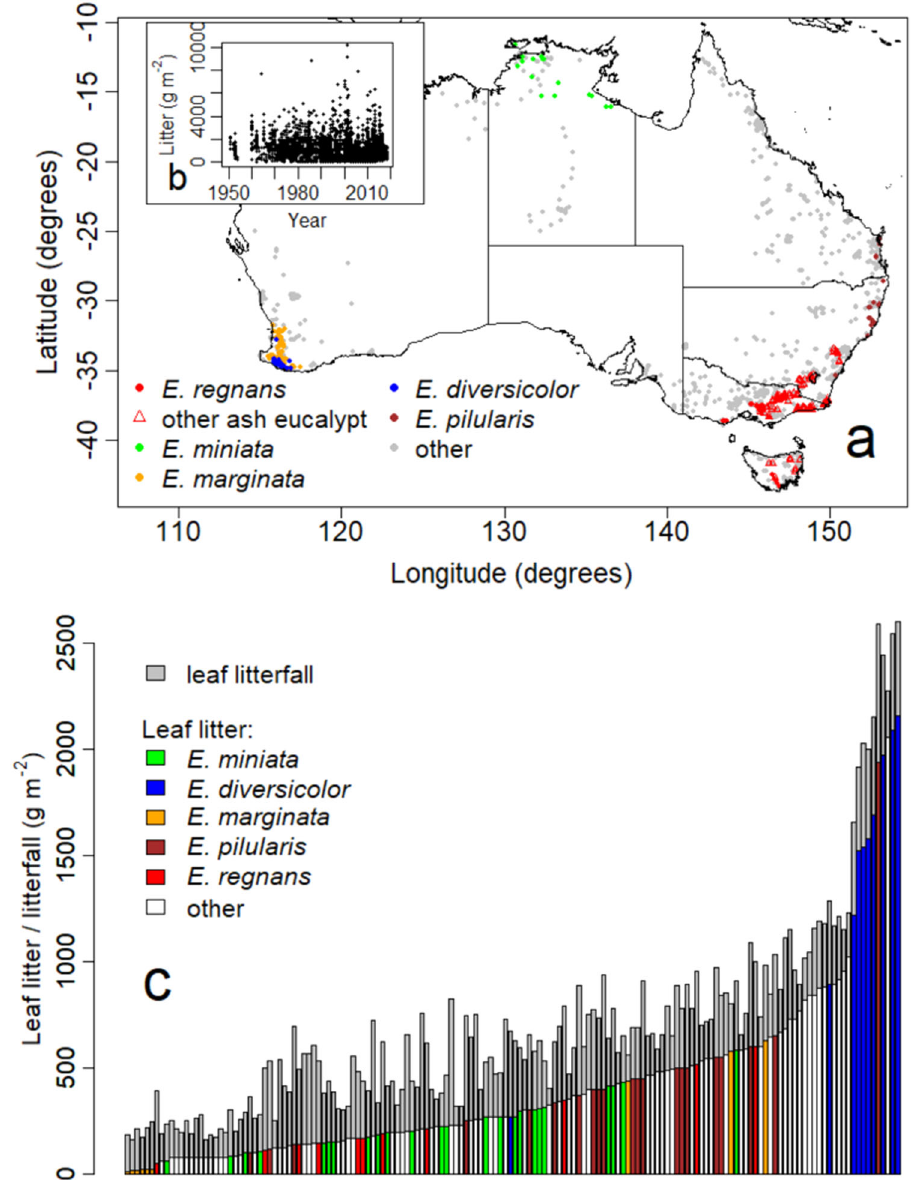
Fig. 1 | Leaf litter and litterfall observations for individual locations on the Australian continent. a Geographic locations of observations. b Relationship of observations for litter to year of sampling. c Mass of leaf litter or leaf litterfall for